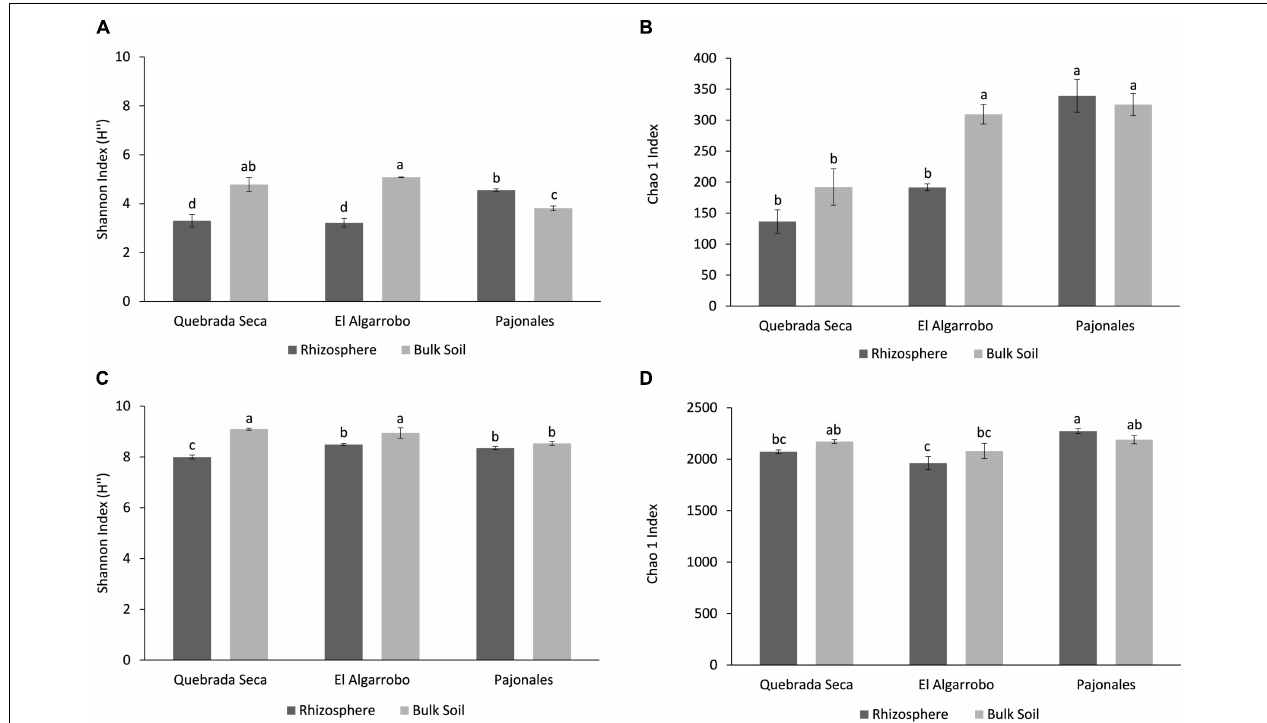
FIGURE 2 | Alpha-diversity analysis per locality and sample type (rhizosphere and bulk soil). (A) Shannon Index for fungi; (B) Chao1 Index for fungi; (C) Shannon Index for prokaryotes; (D) Chao1 Index for prokaryotes. Different letters above the bars indicate statistically different means (Tukey test p <